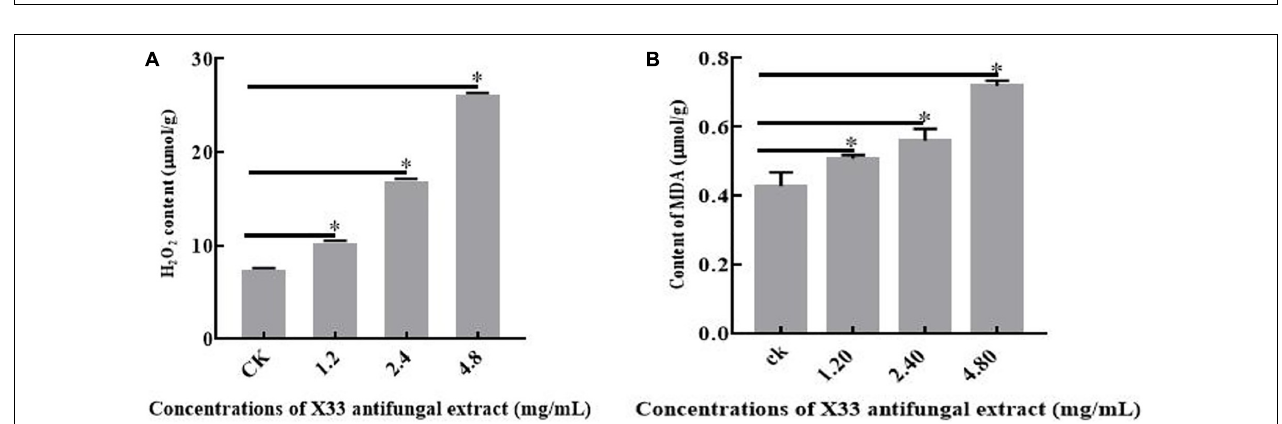
FIGURE 7 | Effects of X33 antifungal extract incubation on the oxidative stress of mycelia of P. digitatum . (A) Lipid Peroxidation. (B) H 2 O 2 content. * p < 0.05.